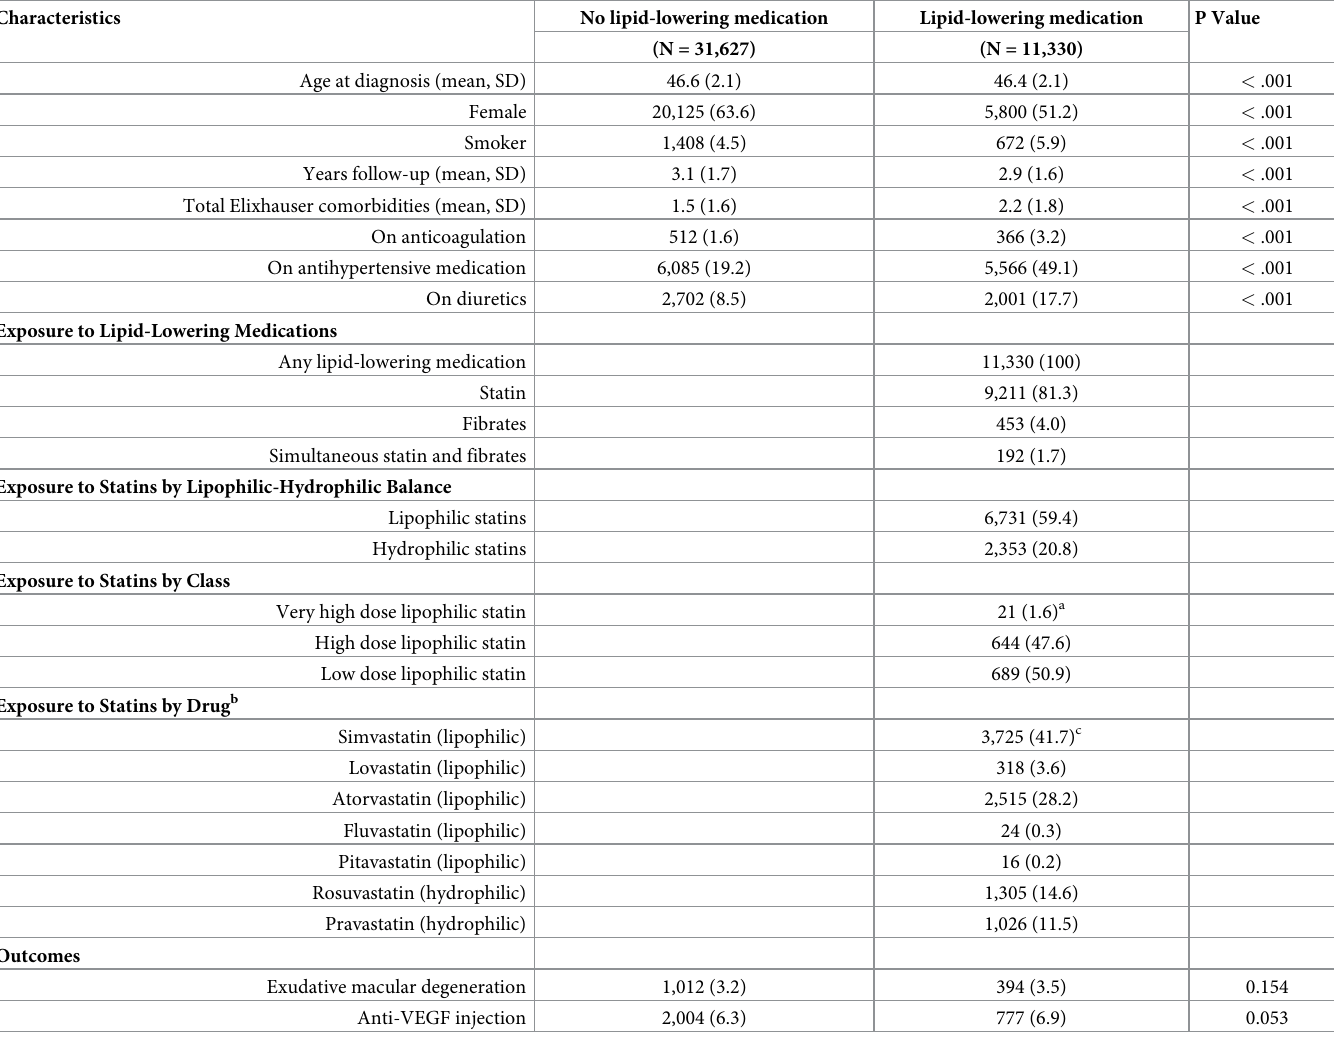
Table 1. Characteristics: Baseline characteristics of patients diagnosed with non-exudative age-related macular degeneration between 2008 to 2015.